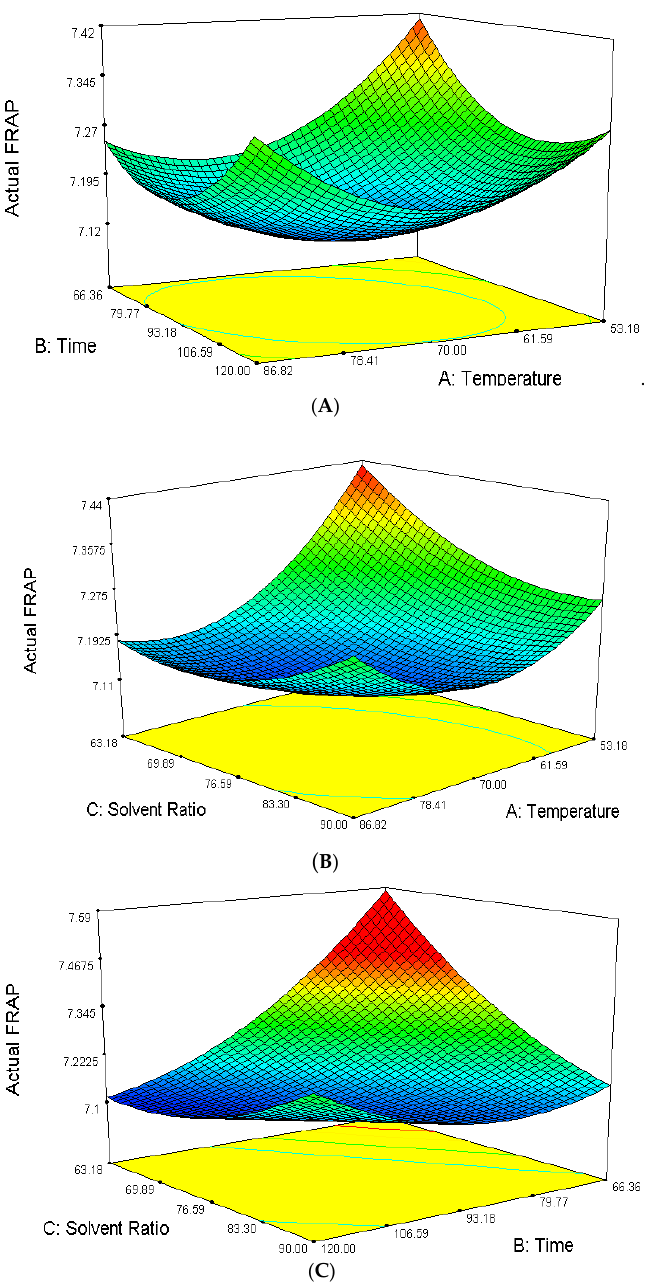
Figure 3. Response surface analysis (3D) on the effect of extraction temperature, ethanol concentration and extraction time on FRAP of P. macrocarpa fruit extract. ( A ) Ferric Ion Reducing Power Assay, FRAP (%); ( B ) Ferric Ion Reducing Power Assay, FRAP (%); ( C ) Ferric Ion Reducing Power Assay, FRAP (%).